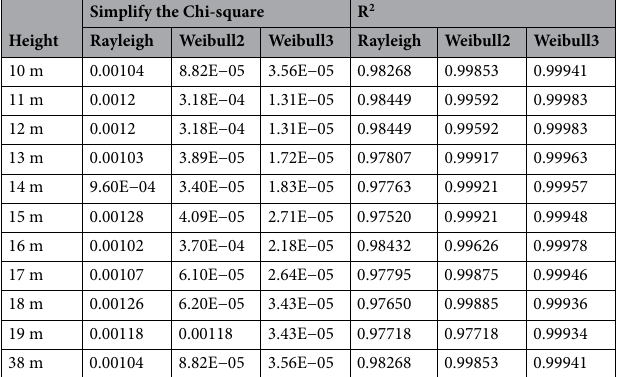
Table 5. Chi-square goodness and R 2 of fit test.